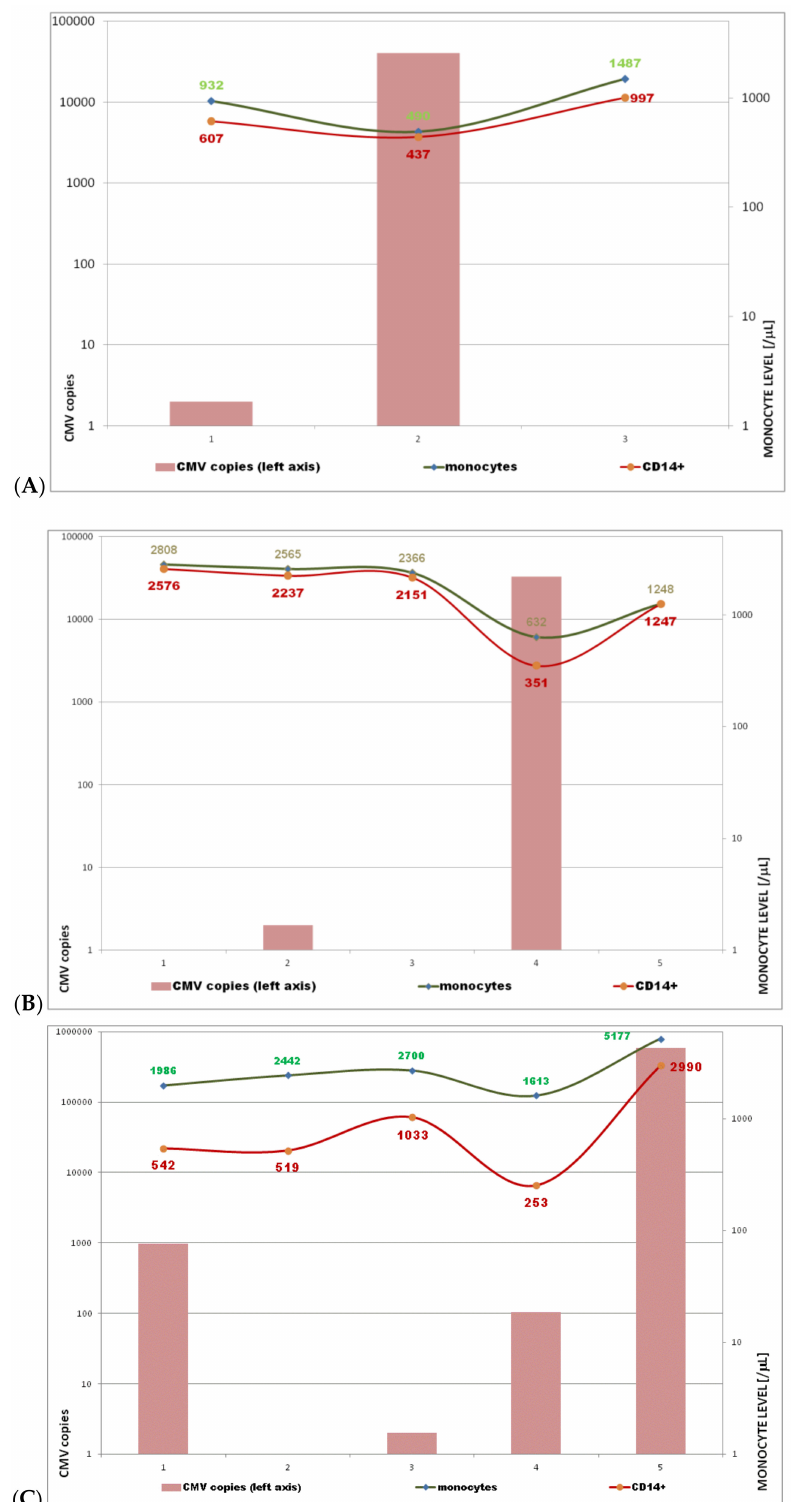
Figure 4. Relationship between CMV-DNA and monocyte count. Monocyte level and CMV copy numbers on 10 5 nucleated cells of the whole blood (as the box) were expressed on the right and left axis, respectively.] According to the guidelines and diagnostic chain (see section Material and Methods), the CMV monitoring was carried out once a week. The course of CMV disease is